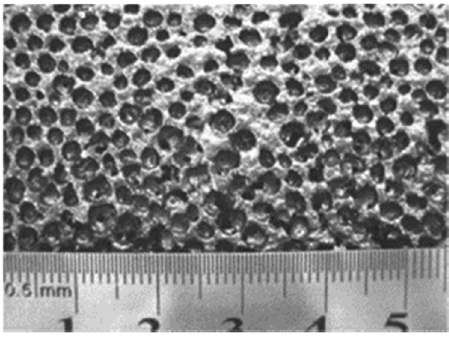
Figure 8: Porous structure of a closed - cell ceramic foam [ 47 ] .